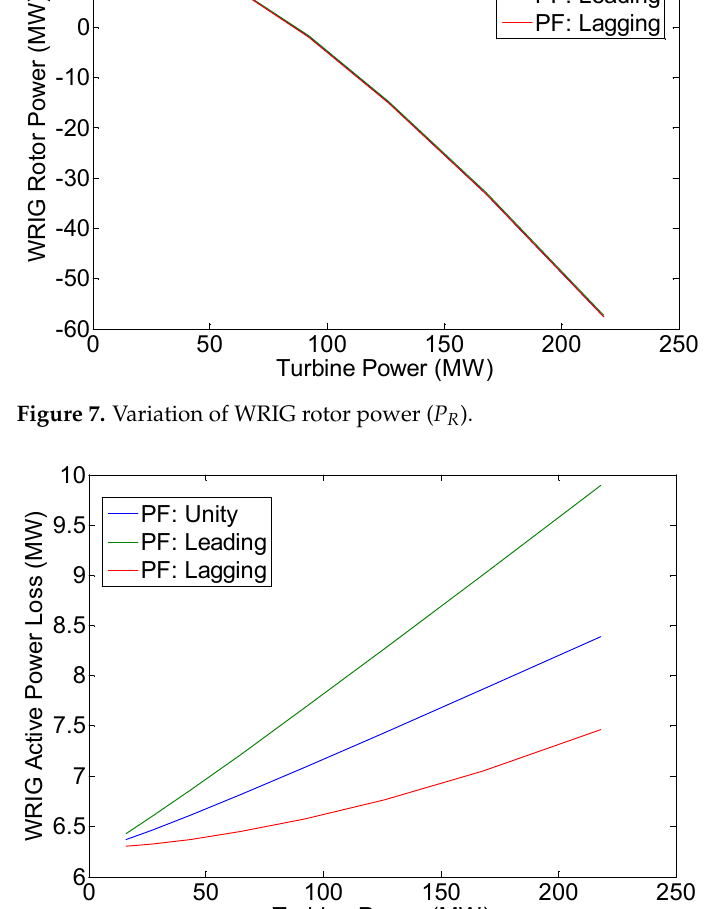
Figure 8. Variation of WRIG active power loss ( P LOSS ).